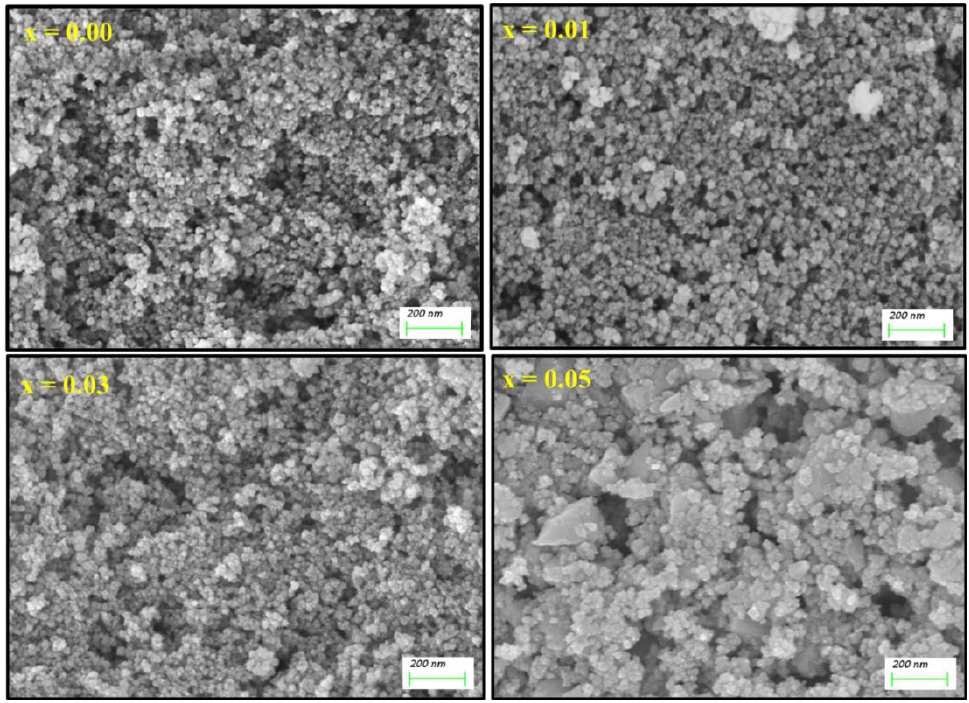
Figure 2. SEM images of (Co 0.5 Ni 0.5 )[Tm x Tb x Fe 2−2x ]O 4 NSFs with x = 0.00, 0.01, 0.03 and 0.05.